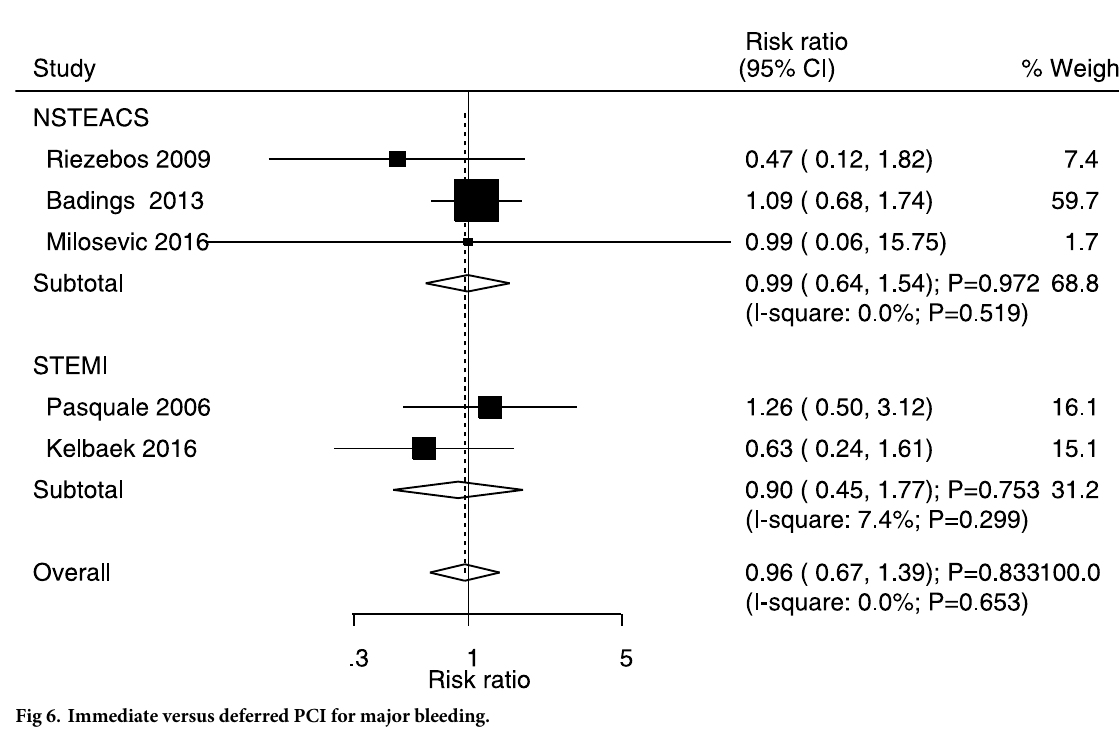
Fig 6. Immediate versus deferred PCI for major bleeding.